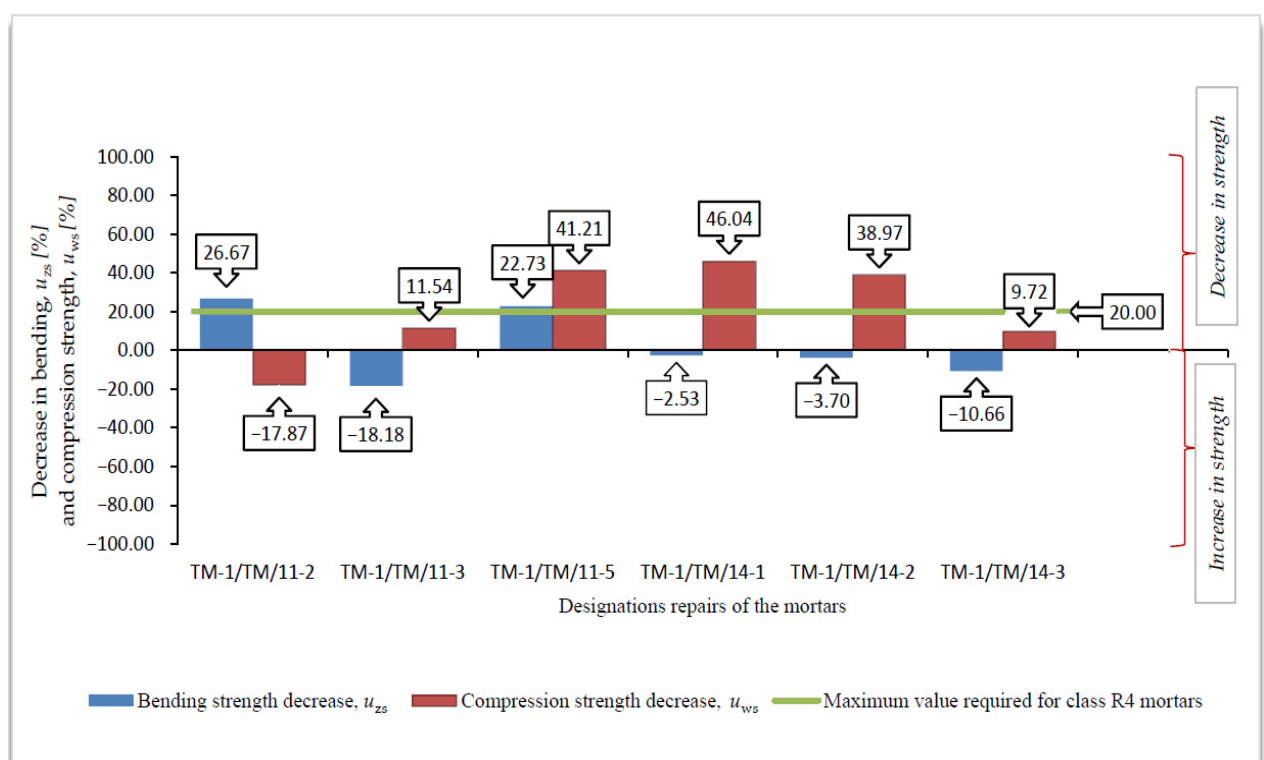
Figure 10. Summary of average values of decrease in bending u z [%] and compression strength u w [%] of R4 class mortar after frost resistance testing, according to [19].